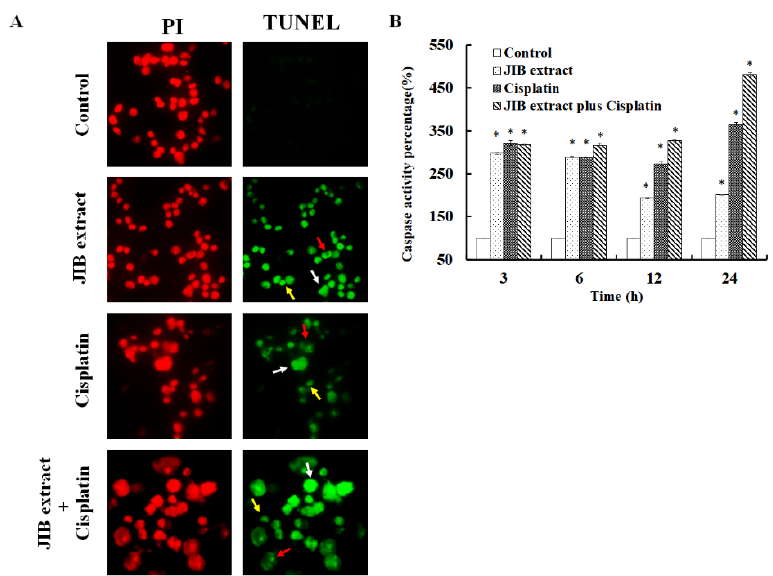
Figure 5. Induction of the caspase cascade after treatment with JIB extract plus cisplatin. OECM-1 cells were treated with JIB extract, cisplatin or a combination of JIB extract and cisplatin for 48 h. Then, the cells were collected, and TUNEL staining was carried out according to the manufacturer’s instructions. Red: PI; green: TUNEL-positive; white arrow: DNA fragments; red arrow: anoikis; yellow arrow: